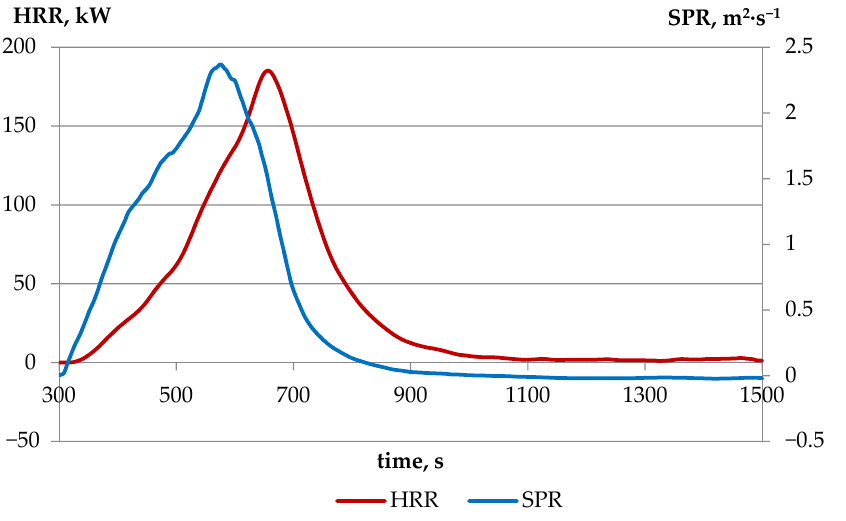
Figure 12. Heat release rate and smoke production rate results for a PVC-insulated and sheathed coaxial power cable.